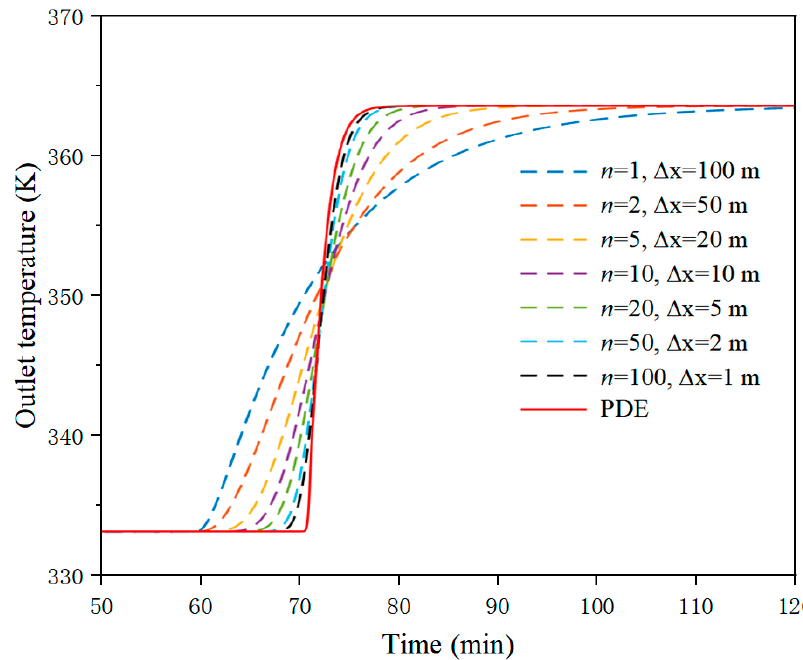
Figure 7. Response of outlet temperature under different discretization.